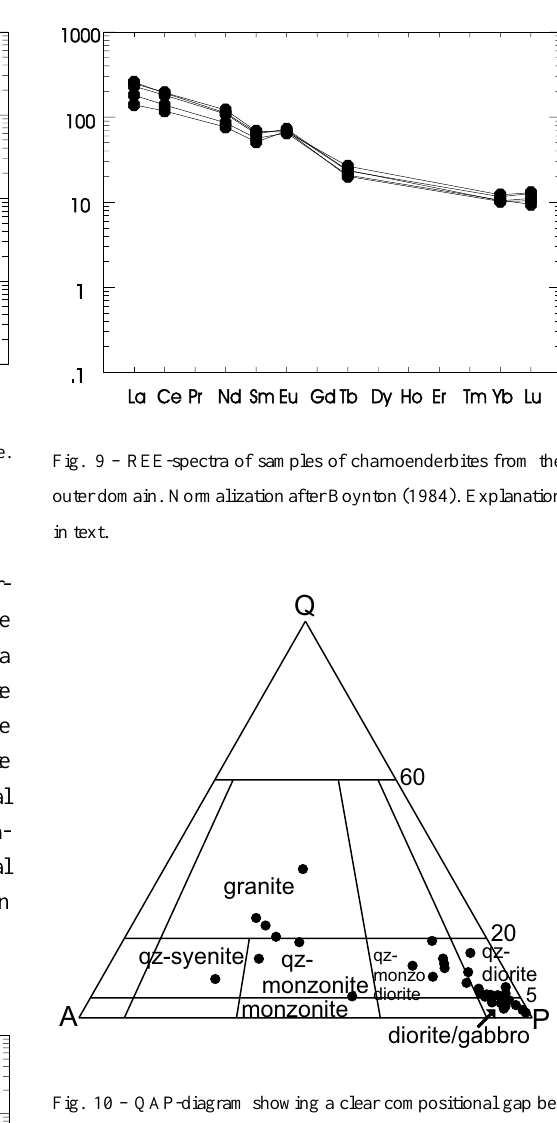
Fig. 10 – QAP-diagram showing a clear compositional gap be- tween mafic and felsic